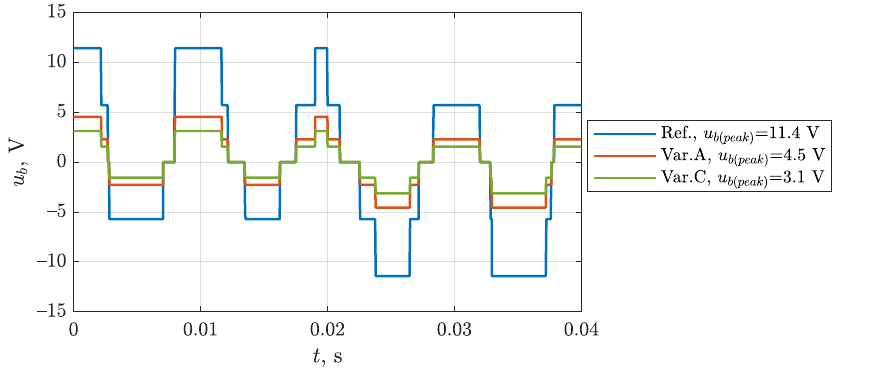
Figure 21. Bearing voltage waveforms for the three-level converter model for selected solution var- iants.